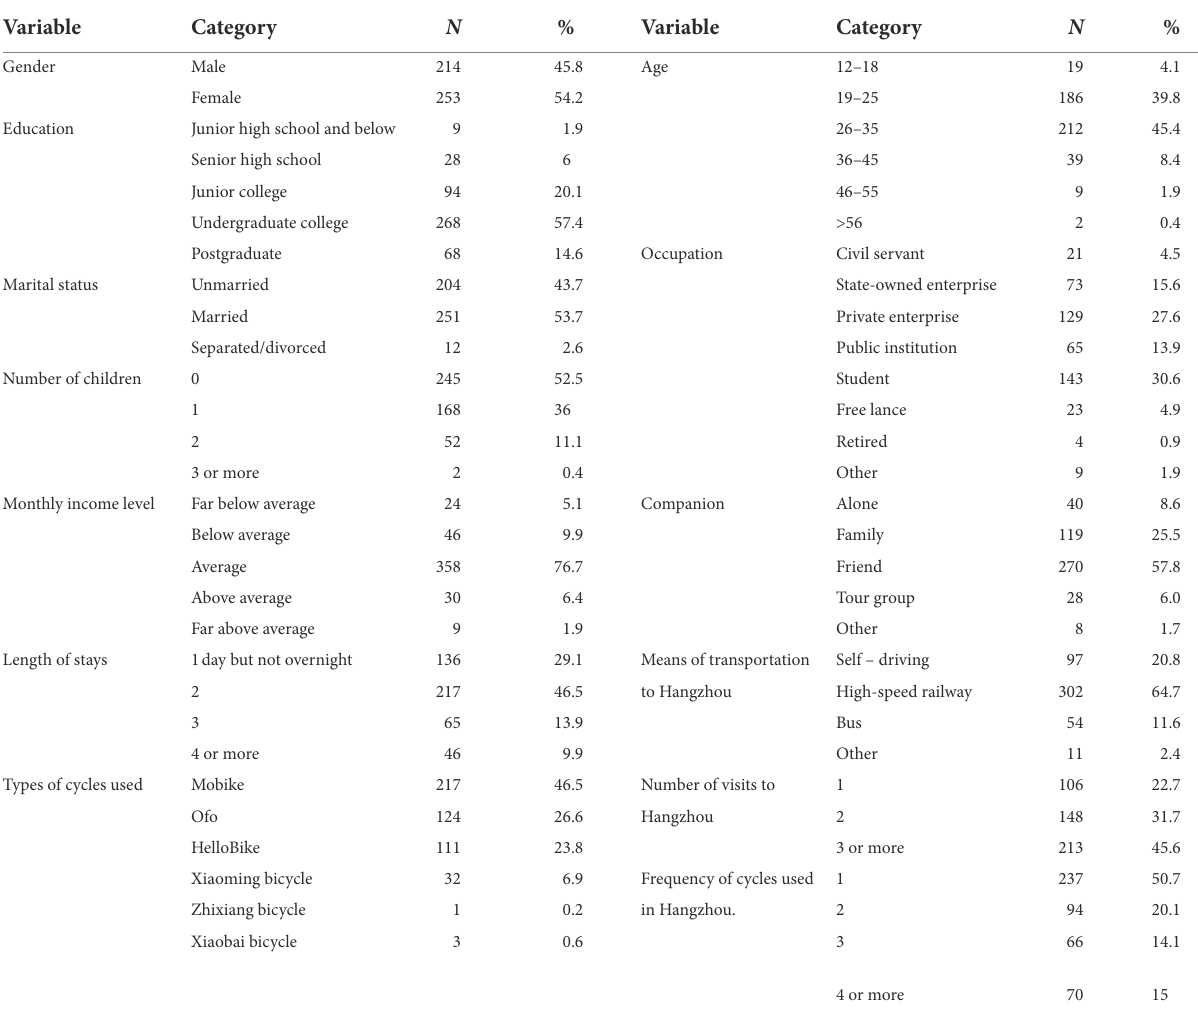
TABLE 1 The descriptive statistics of sample characteristics ( n =